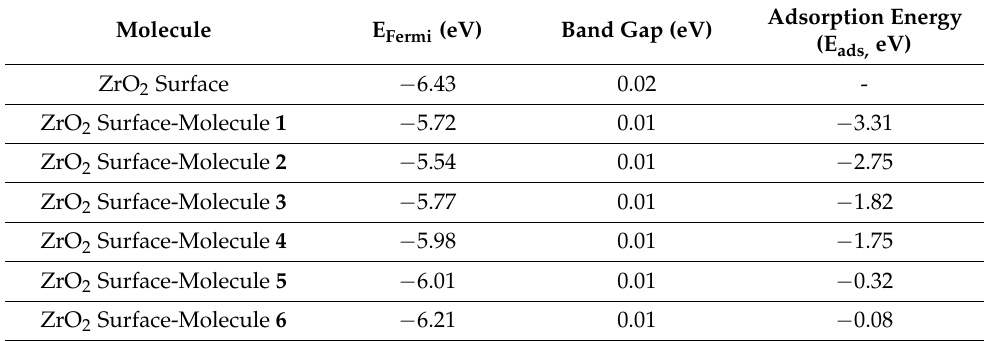
Table 2. Adsorption energy calculations for the Biginelli intermediates and products.